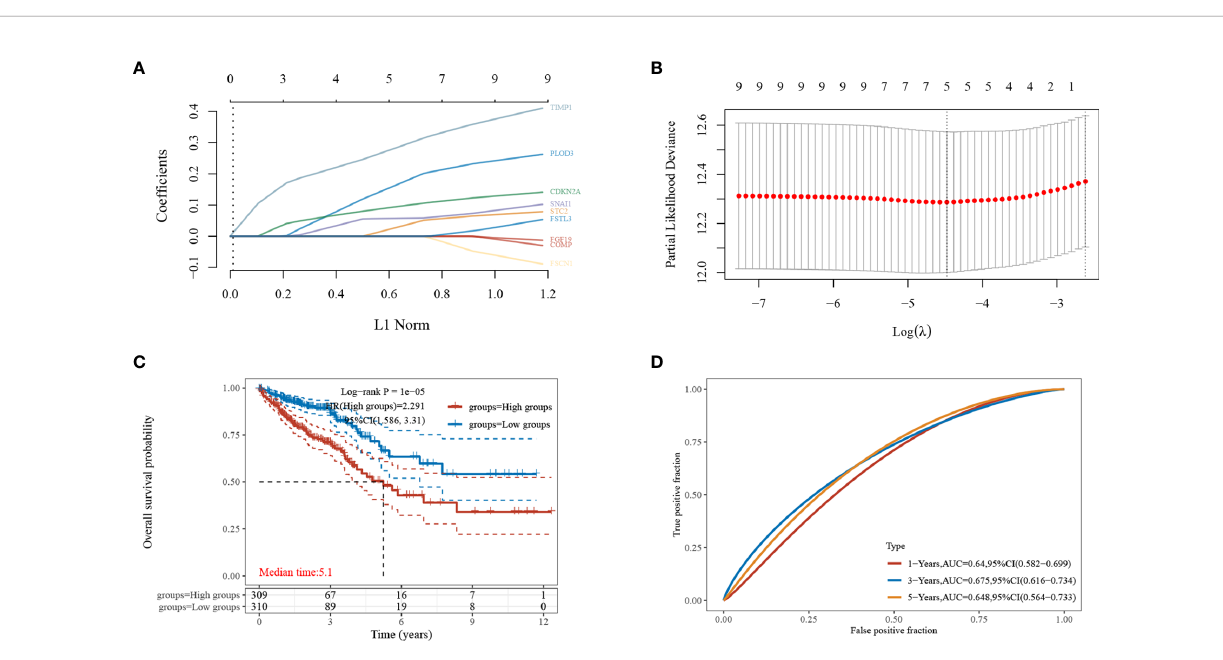
FIGURE 3 | Establishment of the least absolute shrinkage and selection operator (LASSO)-Cox prognostic model. (A, B) Selected characteristic coef fi cients are shown by lambda parameters, and the number of prognostic factors was determined using LASSO regression analysis; (C) distribution of high and low risk samples; (D) KM survival analysis of the high- and low-risk samples for CRC in the TCGA